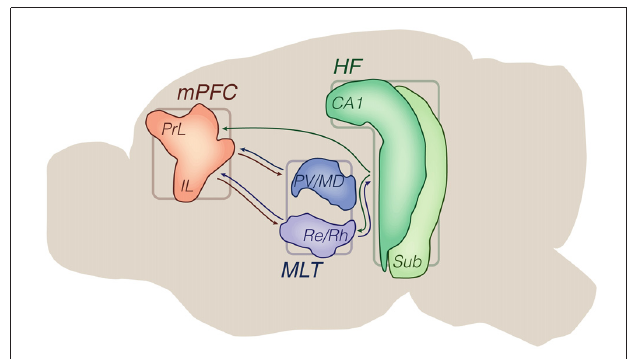
FIGURE 1 | Principal brain areas and axonal projections of the delimited literature. Mid sagittal view of the rodent brain. Other brain sites are illustrated in subsequent figures (e.g., ventral tegmental area (VTA), basolateral amygdala (BLA), striatum). Arrows from the hippocampal formation (HF) are generically positioned, i.e., no distinction is made between dorsal, intermediate and ventral domains. Drawings are based on the Brain Explorer 3D atlas (Allen Institute). Abbreviations: CA1, cornus ammonis 1; HF, hippocampal formation; IL, infralimbic area; MLT, midline/paramidline thalamus; mPFC, medial prefrontal cortex; PrL, prelimbic area; paraventricular (PV)/mediodorsal thalamus (MD), PV/mediodorsal nuclei; Re/Rh, reuniens/rhomboid nuclei; Sub,